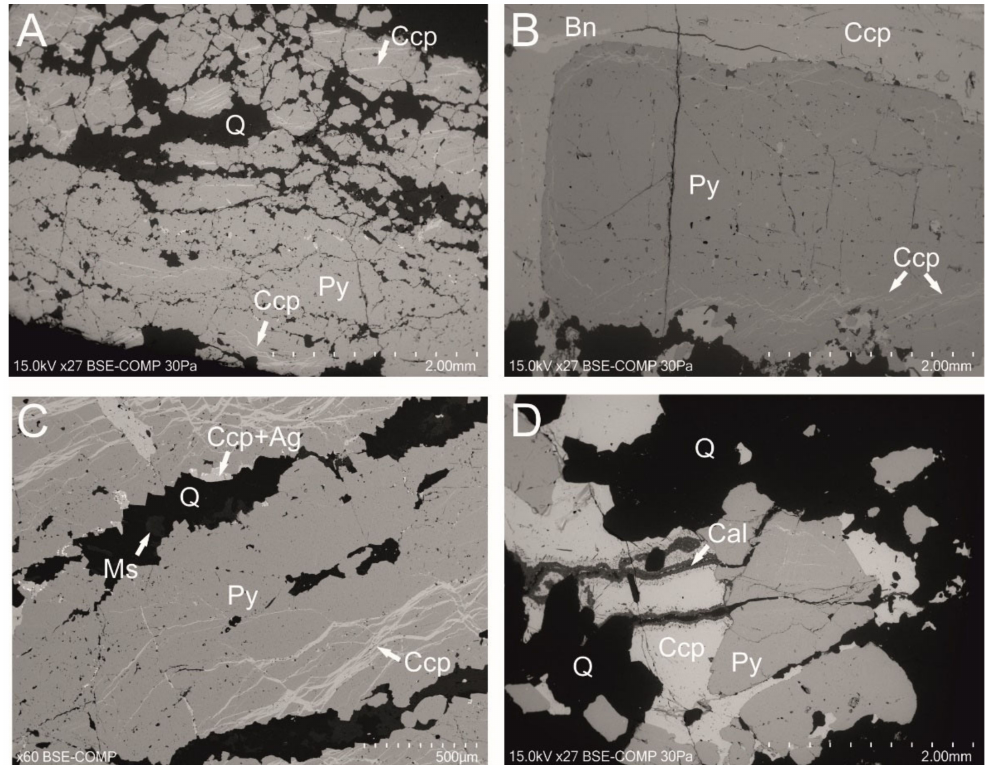
Figure 4. ( A – D ) SEM back-scattered images of Py-II (feldspathic, pegmatitic quartz veins). ( A ) Aggregates of subhedral to anhedral grains of Py-II, ( B ) Chalcopyrite veinlets in Py-II, ( C ) Py-II with numerous voids (relics of fluid inclusions or dissolution–reprecipitation processes?) and chalcopyrite veinlets, ( D ) Py-II associated with bladed calcite. Abbreviations: Py—pyrite, Q—quartz, Ccp—chalcopyrite, Ms—muscovite,